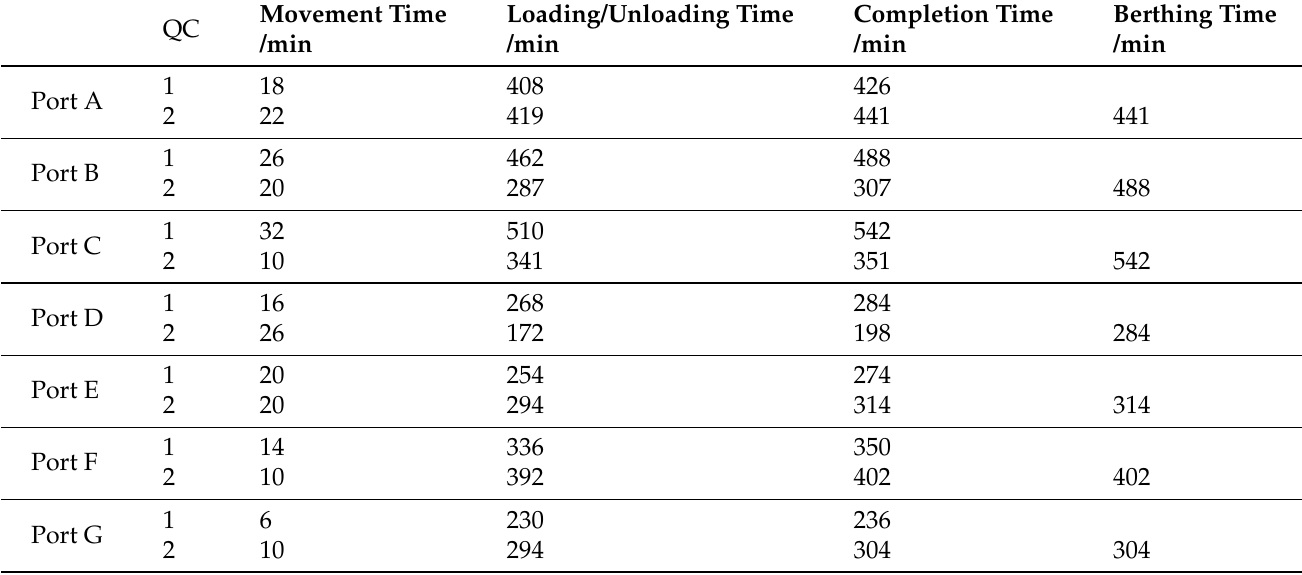
Table 7. Results of the single-bay rule